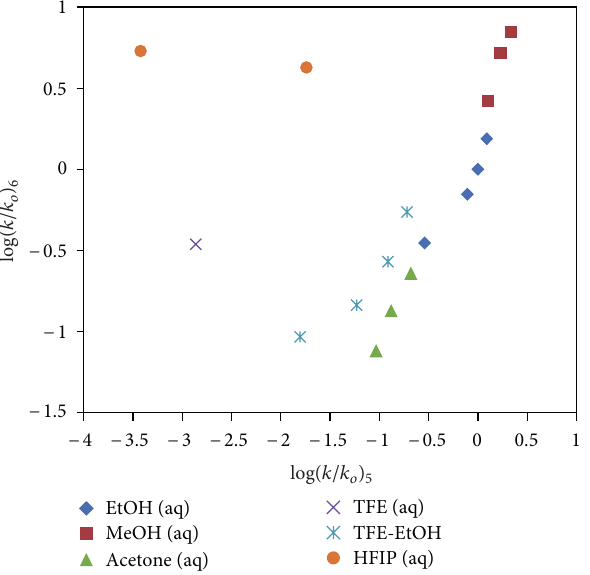
-test value. e Values taken from [26, 27]. f Values taken from [25, 26]. 𝐹𝐹